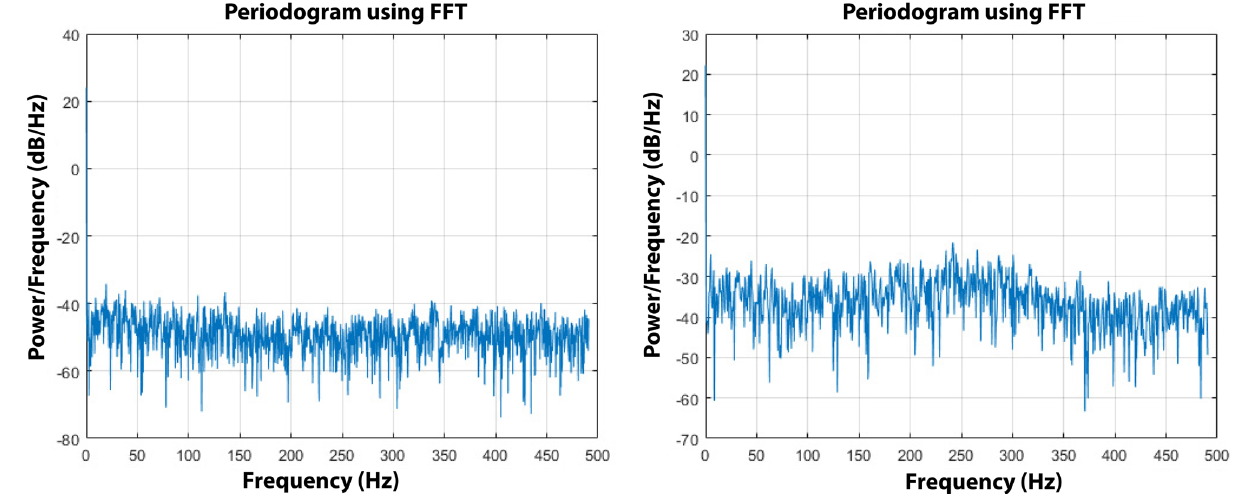
Figure 13. Periodogram from vertical accelerations over concrete, on the left, and over asphalt, on the right, during straight motion.